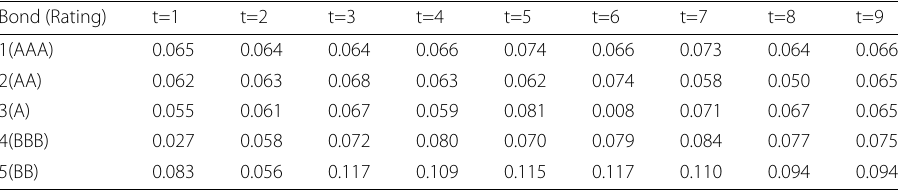
Table 4 Average simulated returns for Industry Sector